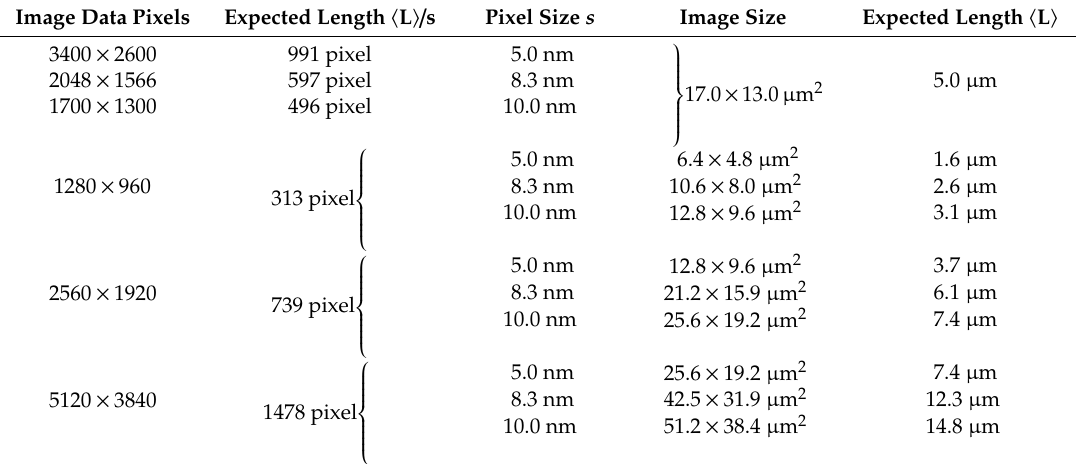
Table 3. Calculated expectation values for aspect ratio and length of randomly placed and randomly oriented straight fibers that are fully contained in an image frame of P x · P y pixels at a pixel size s . Lengths below the WHO cut-o ff length of 5 µ m are marked in